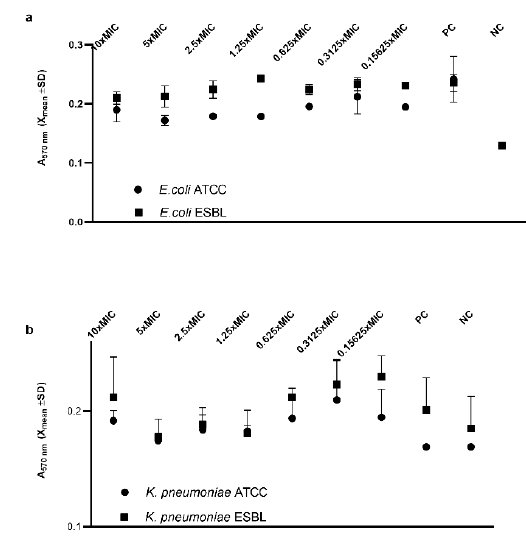
Figure 3. ( a ) Effects of various concentrations of platinum nanoparticles on preformed (mature) biofilms of E. coli ATCC and E. coli ESBL compared to the control. ( b ) Effects of various concentrations of platinum nanoparticles on preformed (mature) biofilms of K. pneumoniae ATCC and K. pneumoniae ESBL compared to the control. A 570nm —absorbance at 570 nm wavelength; PC—positive control (untreated bacteria); NC—negative control (sterile medium).